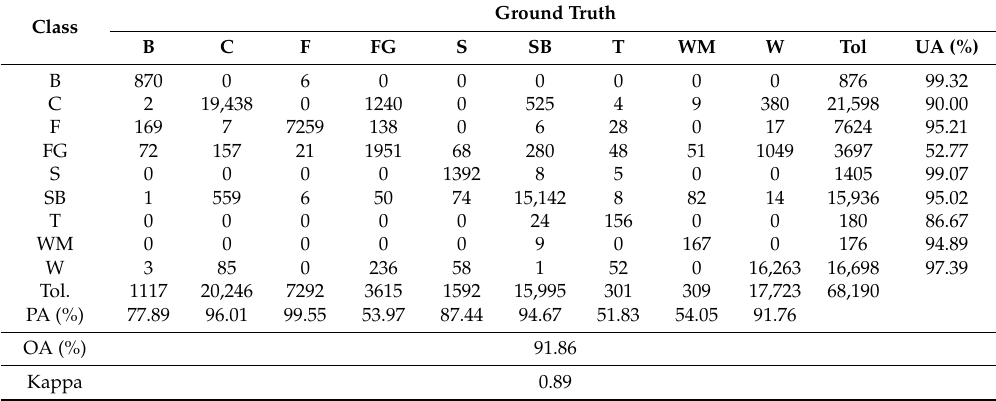
Table 6. The confusion matrix for the land cover mapping obtained using CP-RF method using all 11 RADARSAT-2 images (B, built-up; C, corn; F, forest; FG, forage; S, soil; SB, soybean; T, tobacco; WM, watermelon; W,